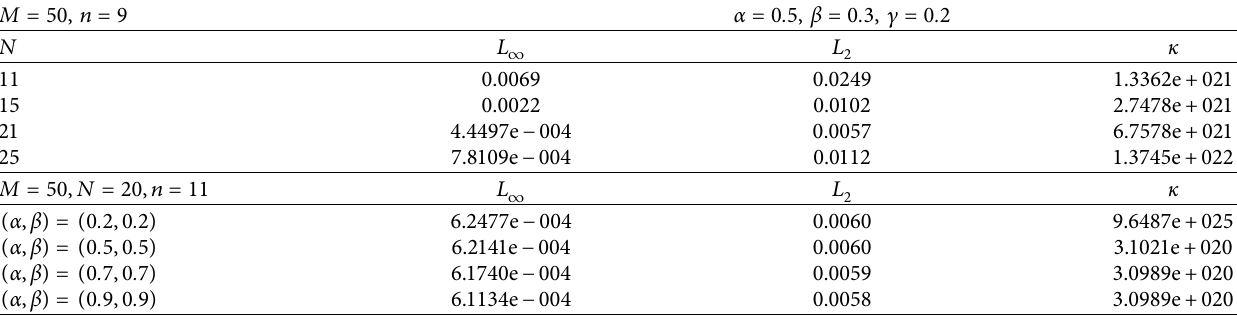
Table 4: Numerical results using the proposed numerical scheme corresponding to Problem 4.